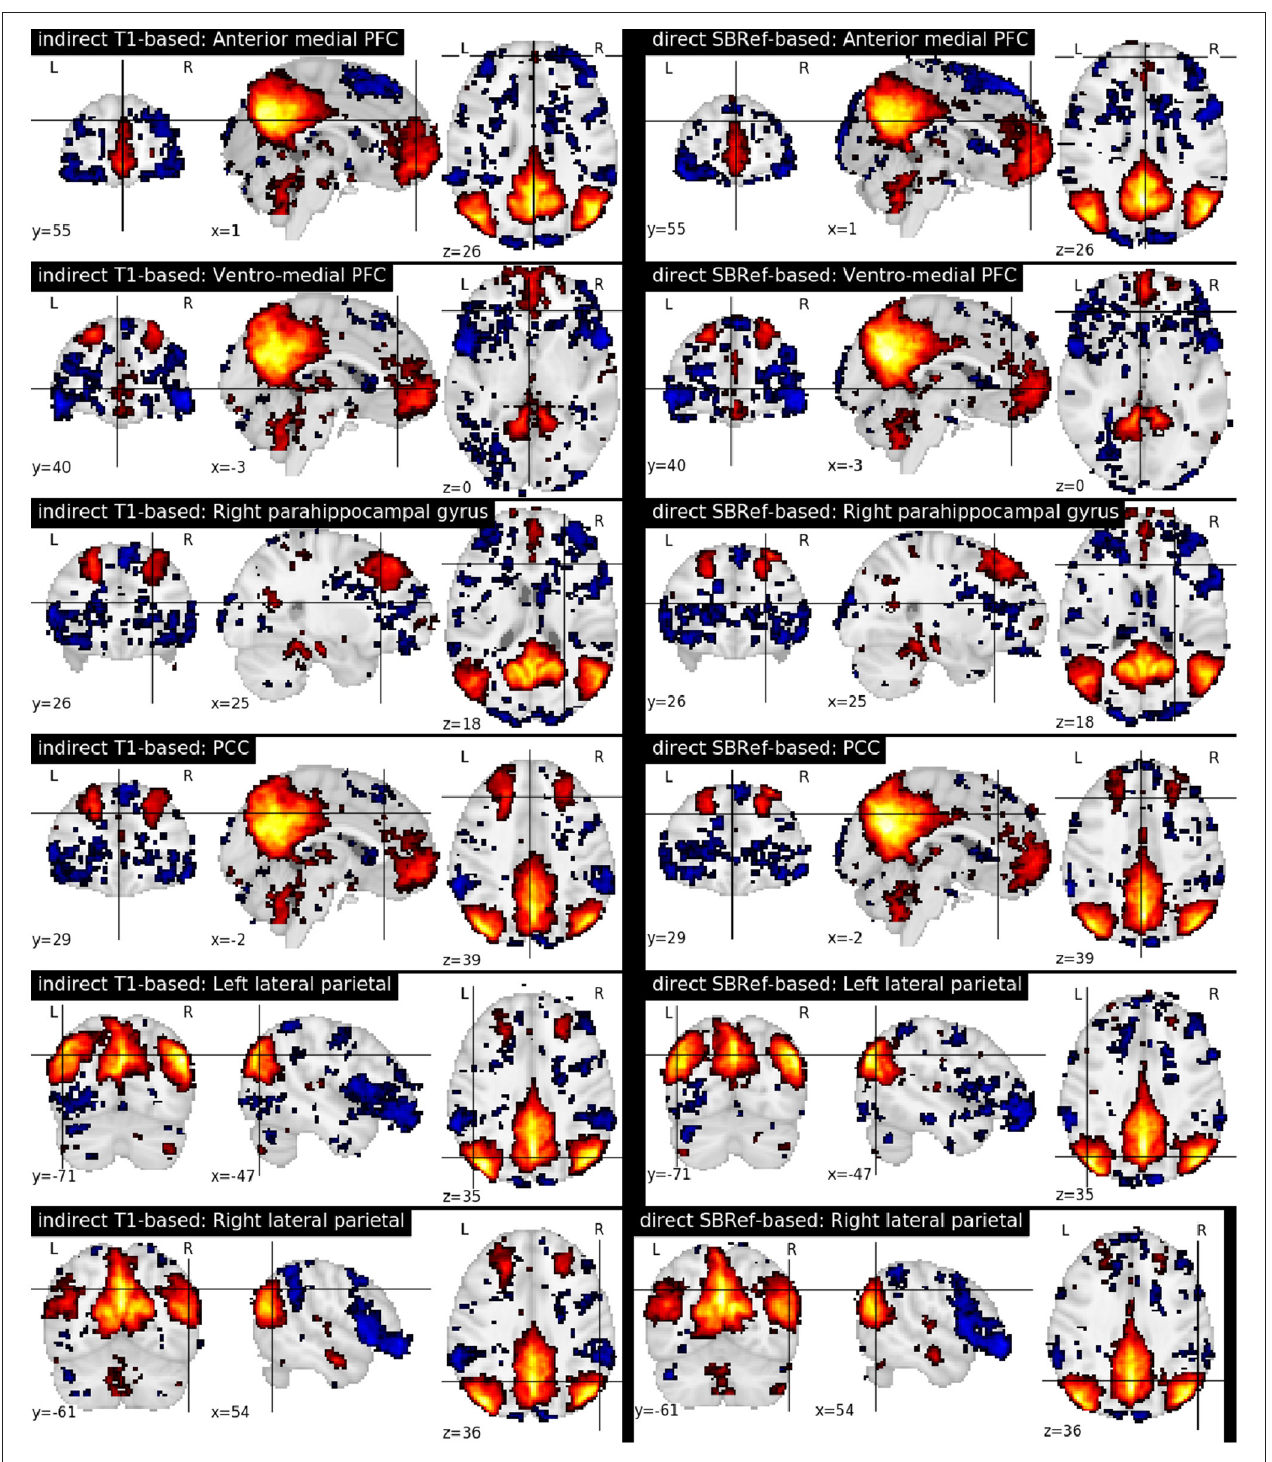
FIGURE 7 | Comparing functional brain networks from subject fMRI images registered with both pipelines, namely the classical indirect T1-based method, and our proposed direct EPI-based method. Shown here are group-level unthresholded sub-component maps of the Default Mode Network (DMN) (Raichle et al., 2001), using MNI coordinates reported in Table 1 of Watanabe et al.